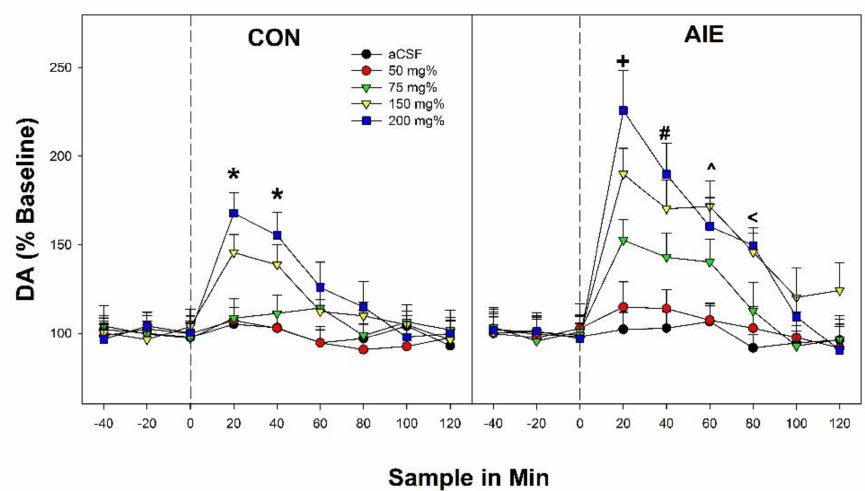
Figure 1. Dopamine levels (%Baseline) in the AcbSh following microinjections of EtOH into the posterior VTA in male Wistar rats that received water treatment (CON; left panel) or binge-EtOH exposure during adolescence (AIE; right panel). * indicates that in CON rats, the 150 and 200 mg% EtOH groups had significantly higher levels of DA in the AcbSh. + indicates that in AIE rats 200 mg% > 150 mg% > 75 mg% > 50 mg% and aCSF, and 75 mg%, 150 mg%, 200 mg% AIE > CON rats. # indicates that in AIE rats 200 mg% and 150 mg% > 75 mg% > 50 mg% and aCSF, and 75 mg%, 150 mg%, 200 mg% AIE > CON rats. ˆ indicates that in AIE rats 75 mg%, 150 mg%, 200 mg% > 50 mg% and aCSF, and 75 mg%, 150 mg%, 200 mg% AIE > CON rats. < indicates that in AIE rats 150 mg%, 200 mg% > 50 mg%, 75 mg%, and aCSF, and 150 mg%, 200 mg% AIE > CON rats. Data are mean ±